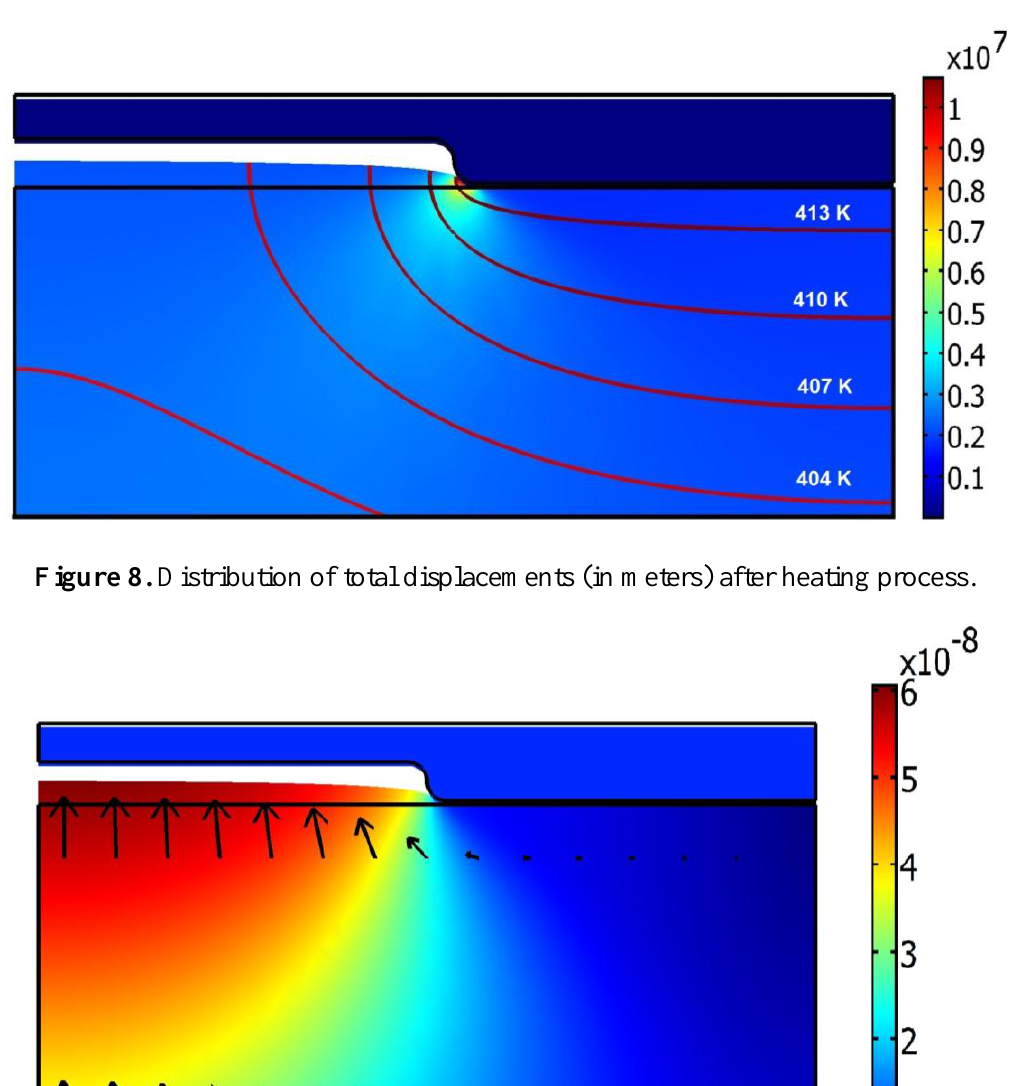
Figure 7. Von Mises stress distribution (color map, Pa) and temperature fields (in Kelvins) represented by lines in the polycarbonate after the heating process.